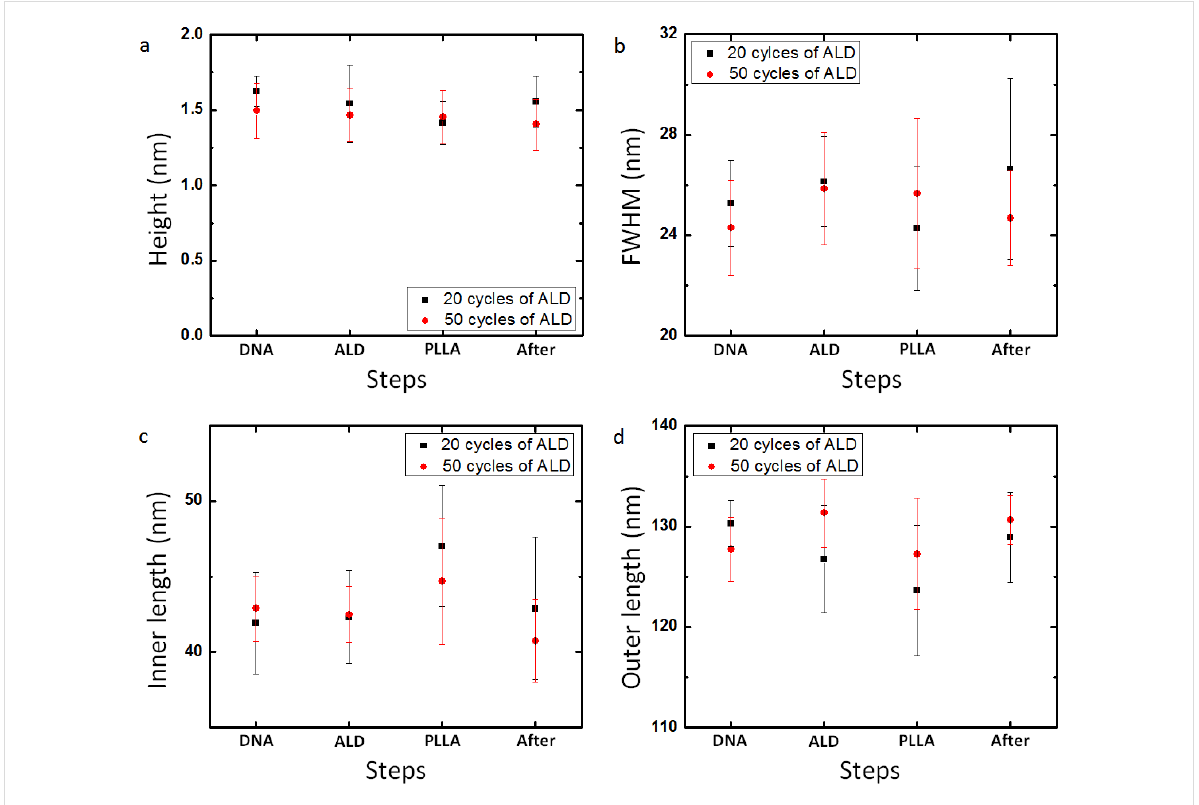
Figure 7: Average (a) height, (b) FWHM, (c) inner length, and (d) outer length (n = 10) of features on DNA origami triangle master templates with a ca. 2 nm or ca. 5 nm of Al 2 O 3 layer and PLLA stamps at each step of fabrication process, after (DNA) DNA origami triangles were deposited on a silicon wafers, (ALD) ALD of Al 2 O 3 , and (After) pattern transfer to PLLA stamps, and (PLLA) their negative replicas on the PLLA